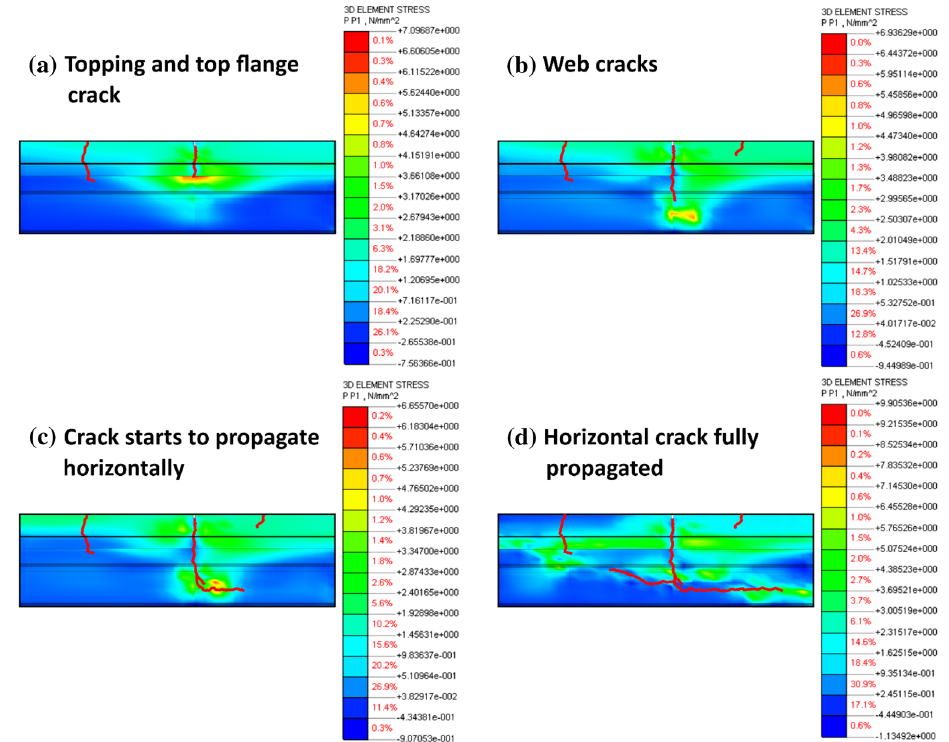
Fig. 11 Progression of principal tensile stresses in the slab during negative loading, up to − 1.0% drift